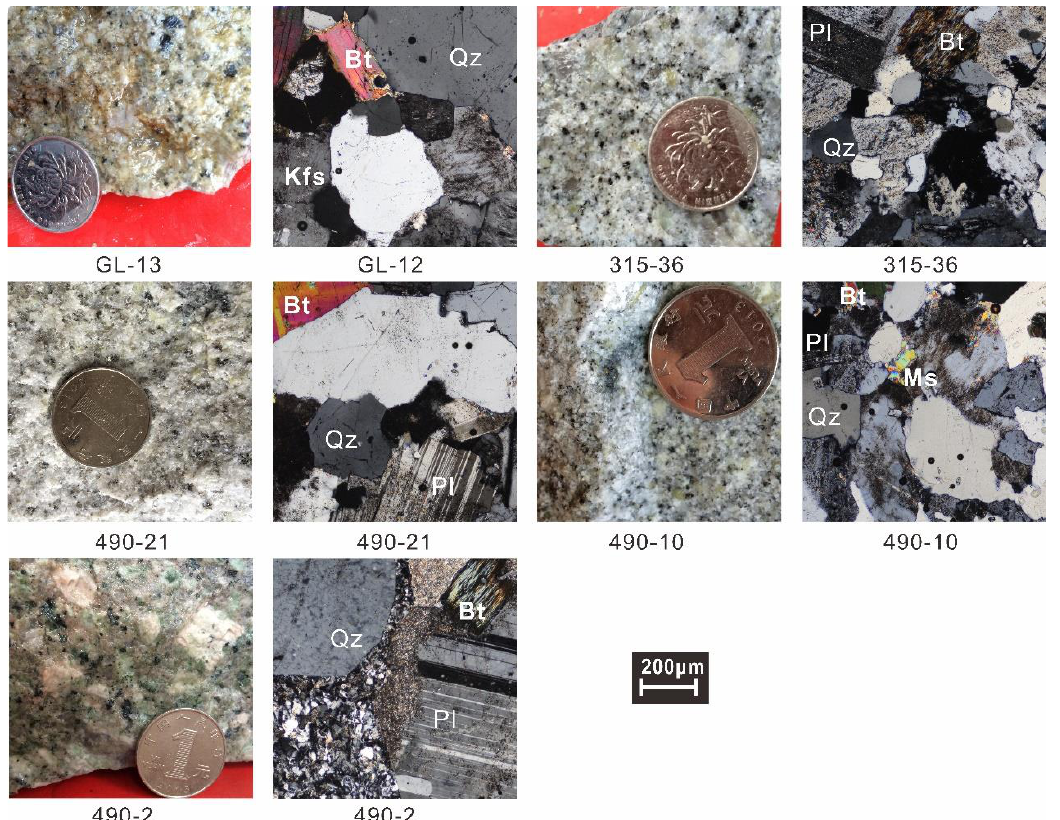
Figure 4. Photographs of the Qianlishan granites. S 1 (Sample GL-13): porphyritic biotite granite; S 2 (Sample 315-36): microfine-grained porphyritic biotite granite; S 3 (Sample 490-21): middle- to large- grained equigranular biotite granite; S 4 (Sample 490-10): fine-grained equigranular biotite granite; S 5 (490-2): granite porphyry dikes (Sample 490-2). Abbreviations [33]: Qz, Quartz; Pl, Plagiarize; Bt, Biotite; Ms, Muscovite; Kfs: potassium feldspar.